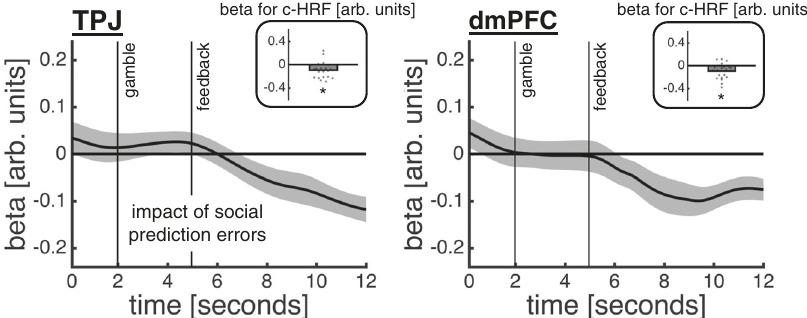
Fig. 9 Encoding of social prediction errors in TPJ and dmPFC. The time courses are coef fi cients from a regression in which we predicted z-scored TPJ (left) and dmPFC (right) activity time courses using z-scored social prediction errors as computed under the best- fi tting ToM-model. The insets show coef fi cients from an analysis of canonical HRFs (c-HRFs; asterisk indicates statistical signi fi cance, p < 0.05, one-sample t -test against zero). Data are represented as group mean ± SEM, n = 21. Source data are provided as a Source Data fi con fi dence estimates on both trial types: activity decreased with con fi dence on other-trials, but increased with con fi dence on self- trials, although the effect on self-trials did not reach statistical signi fi cance (c-HRF regression; con fi dence on other-trials, t (20) = − 2.67, p = 0.015; con fi dence on self-trials, t (20) = 1.79, p = 0.089). The net effect of this inverse response pro fi le in dmPFC is a larger neural distinction between other- and self-trials when con fi dence is low compared to when con fi dence is high.